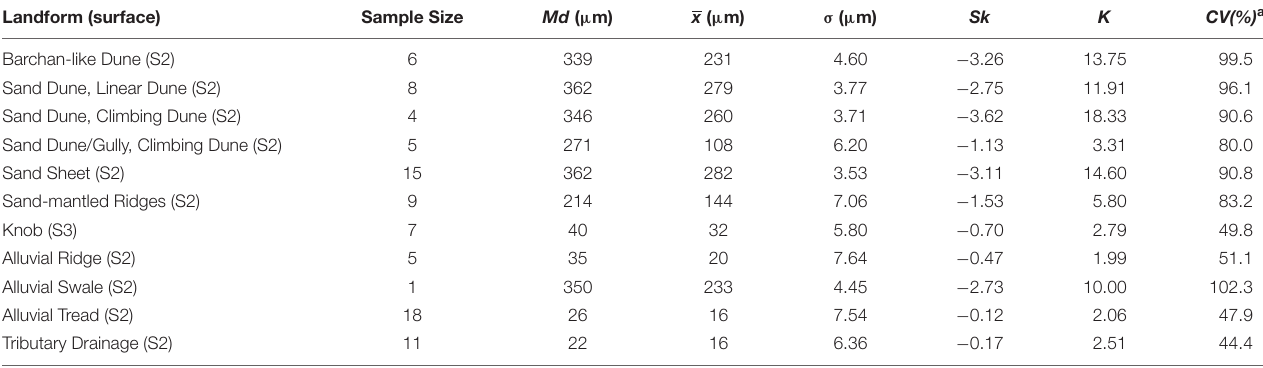
FIGURE 6 | (A) View of lamellae banding in barchan-like dune at ∼ 1 m depth, Section U2. (B) Scan of 5 × 7-cm thin section slide showing lamellae bands highlighted in yellow, black box represents approximate location of (C,D) (open pore space dyed blue). (C) PPL micrograph of well-oriented illuviated limpid clay domains linking grains in lamellae band. (D) same as (C) but in XPL, arrow denotes extinction line indicating continuous orientation of clay domains. TABLE 1 | Particle-size characteristics by landform type for uppermost lithostratigraphic units ( n = 89